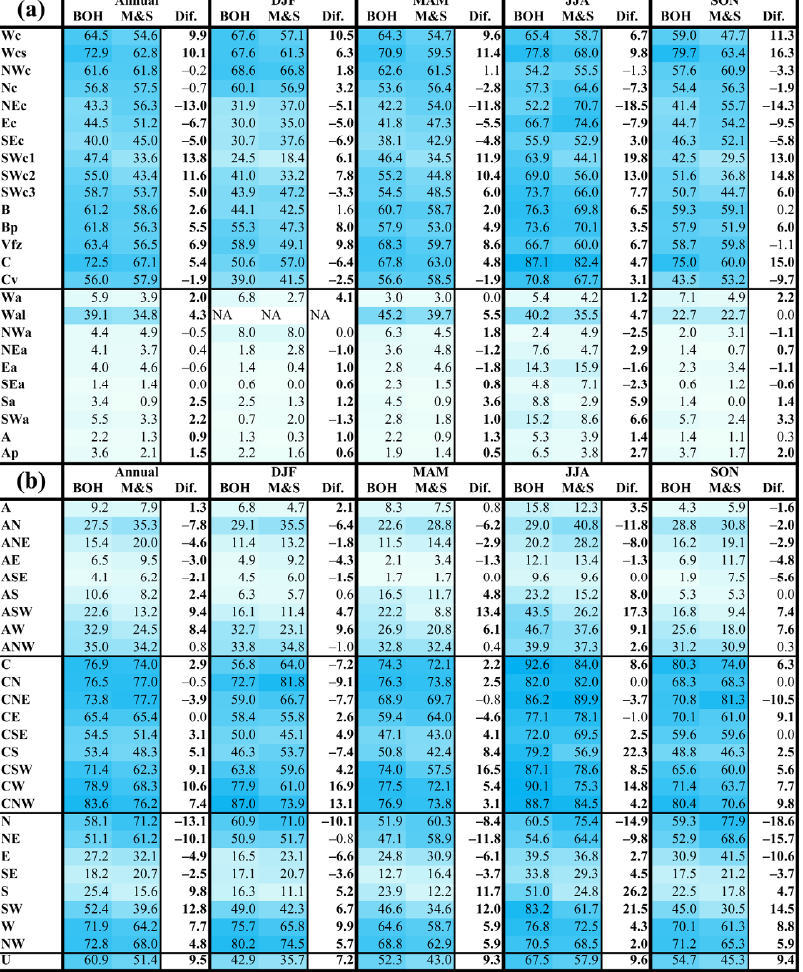
Figure 10. Annual and seasonal (DJF: December–February; MAM: March–May; JJA: June–August; and SON: September–November) probabilities of days with precipitation totals ≥ 1.0 mm for the individual circulation types under the CHMI ( a ) and objective ( b ) classifications in Bohemia (BOH) and Moravia and Silesia (M&S) and differences (Dif) during the 1961–2020 period. Statistically significant differences at the 0.05 significance level are denoted in bold type. The values are highlighted by the color scale of blue shades.